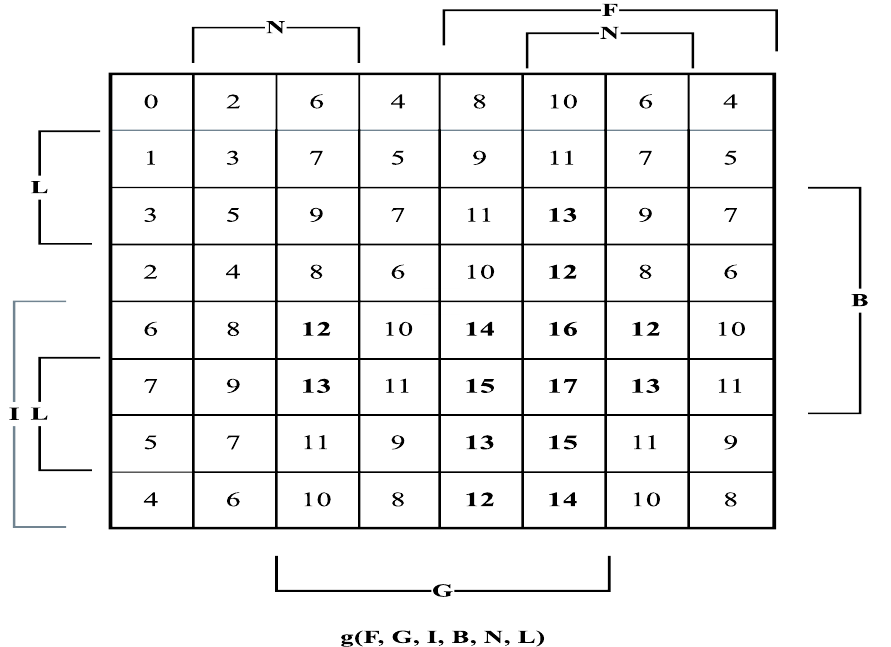
Fig. 3. The pseudo-switching function g with numerical entries representing the sum of the pertinent weights. An entry exceeding or equal to the threshold of 12 is shown bold and occupies a cell of a primitive winning coalition. Other cells represent primitive losing coalitions